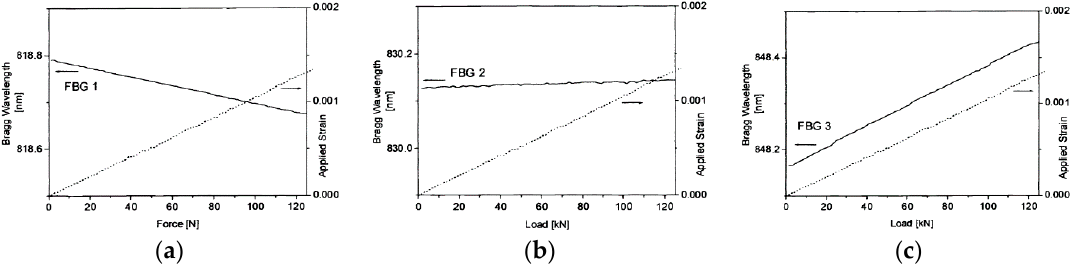
Figure 10. Bragg wavelength change and applied strain vs. load for ( a ) compressed sensor (17 ° ), ( b ) neutral sensor (29 ° ) and ( c ) elongated sensor (40 ° ) [44].